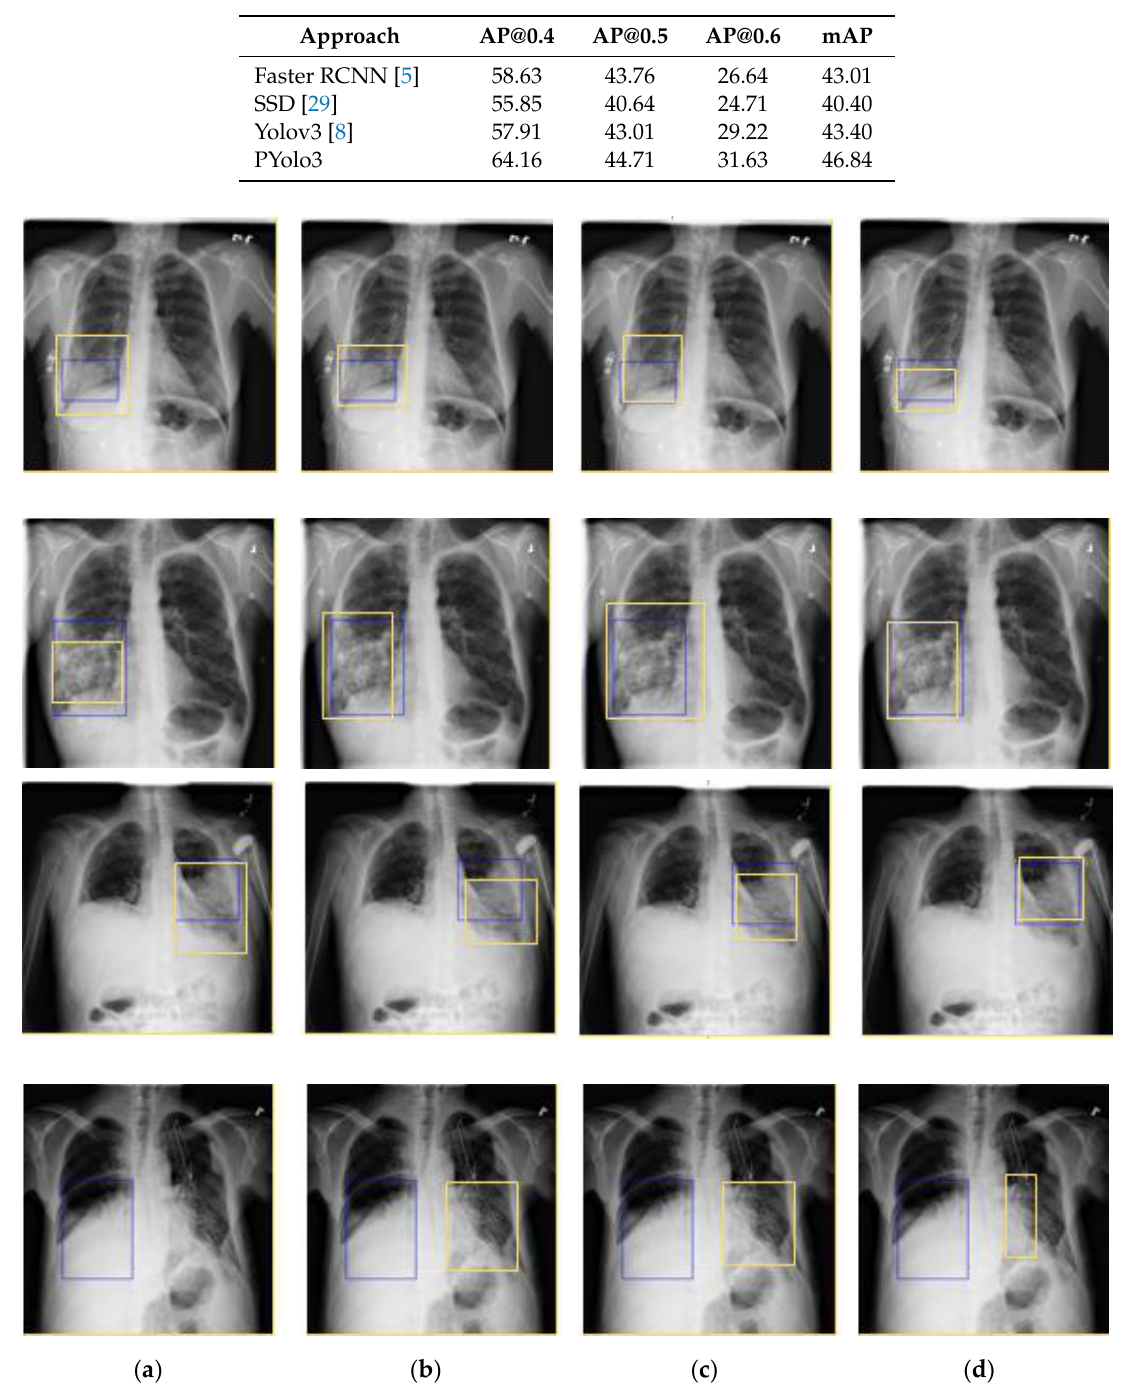
Figure 10. Detection effectiveness of different algorithms. The blue box in each image is the ground-truth box, and the yellow box is the predicted box: ( a ) SSD; ( b ) Faster RCNN; ( c ) Yolov3; ( d ) PYolo. Table 9. Statistical significance (%).